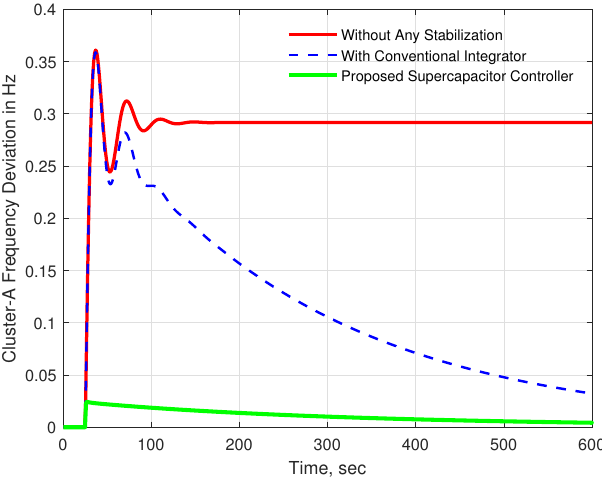
Figure 6. Frequency response for cluster A with 0.01 p.u. disturbance in cluster A. A similar improved frequency response was achieved for cluster B, as shown in Figure 7.